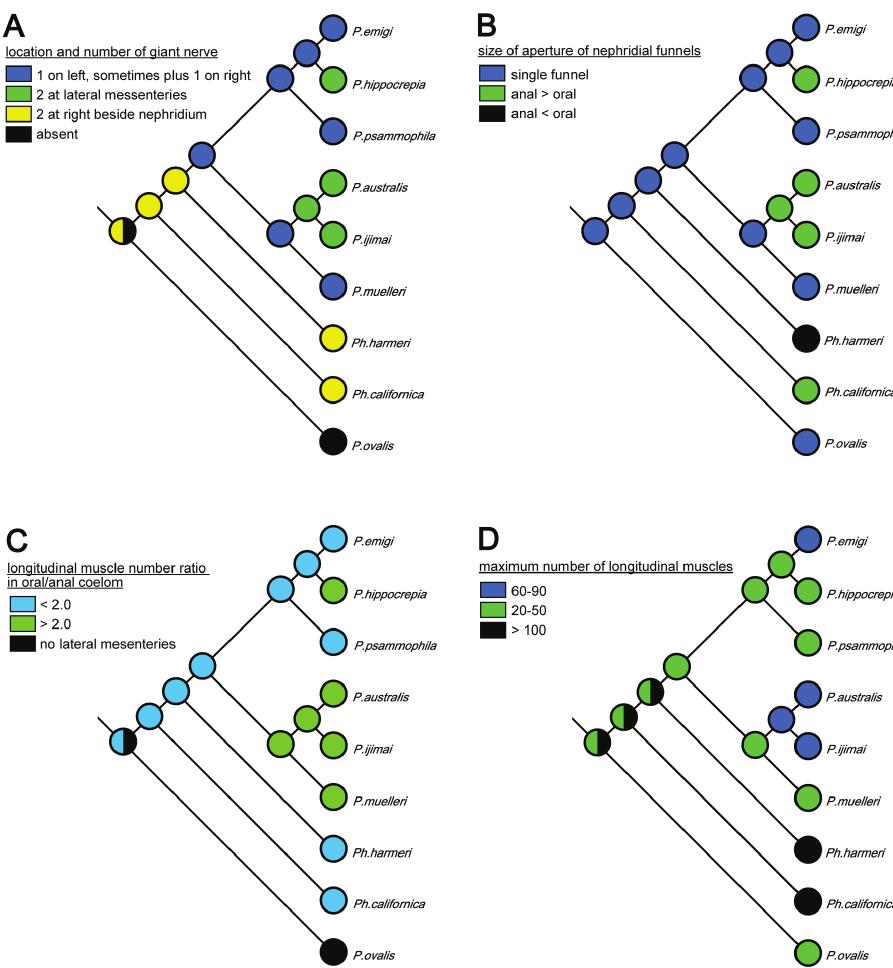
Figure 15. Parsimonious reconstruction of four adult morphological characters among nine phoronid species on the maximum-likelihood tree based on concatenated COI–18S–28S